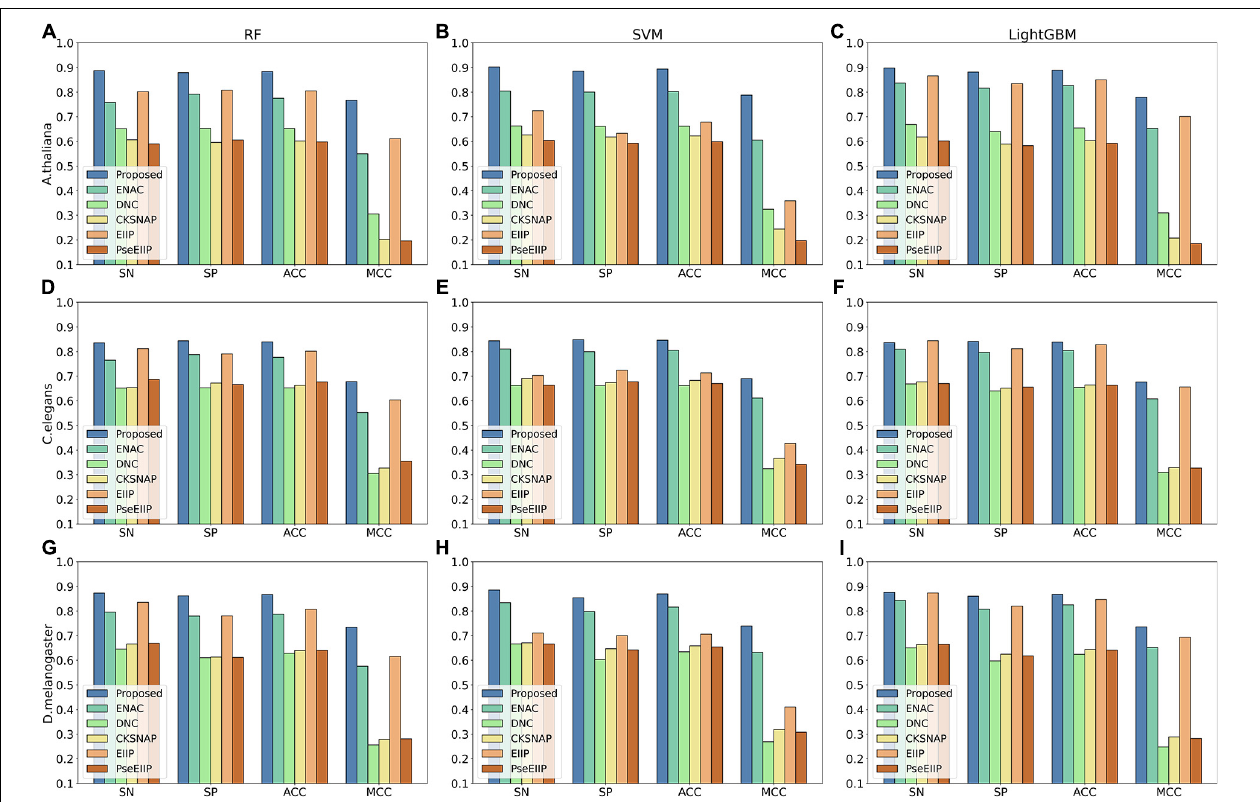
FIGURE 3 | The 10-fold cross-validation results of the Proposed, ENAC, DNC, CKSNAP, EIIP, and PreEIIP methods are based on the three basic classifiers for each species. (A–C) The results of the species A. thaliana . (D–F) The results of the species C. elegans . (G–I) The results of the species D. melanogaster.